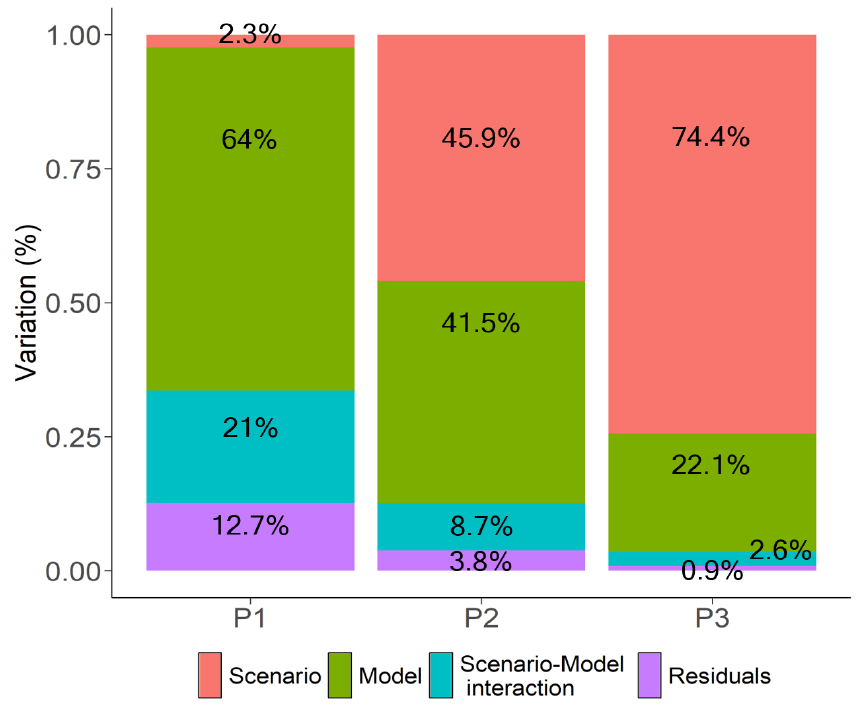
Figure 10. Bar plots (unit: %) representing uncertainties in projecting future climate or the variations owing to the models, scenarios, model and scenario interaction, and residuals for 20-year return levels over the Korean peninsula for each